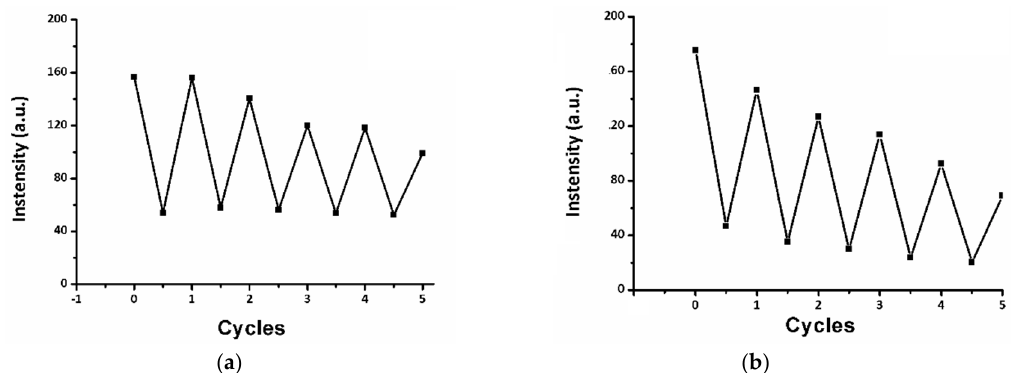
Figure 6. Fluorescence intensity of ( a ) 2b and ( b ) 2d upon the consecutive addition of Cu 2 + followed by EDTA for five cycles in DMSO/HEPES buffer.